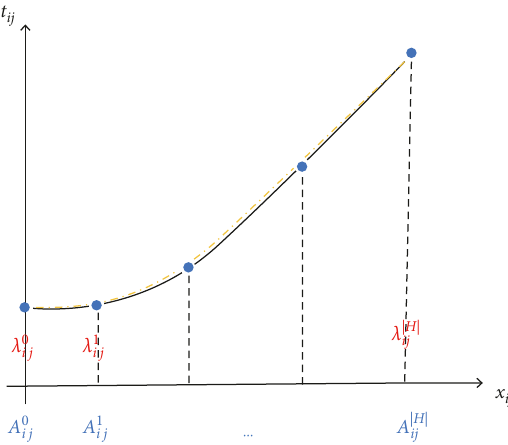
Figure 2: Grids defined for piece-wise linearisation of the BPR